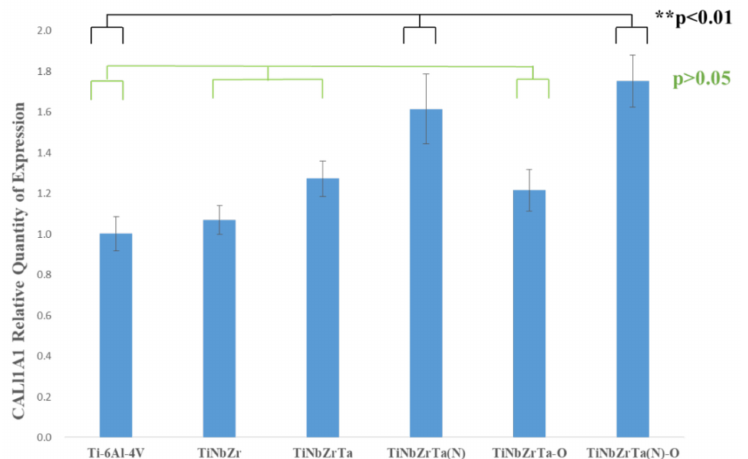
Figure 11. Col1 α 1 gene expression of L-929 cultured on uncoated Ti-6Al-4V and TiNbZrTa series films for three days. ** represents significance among groups ( p < 0.01); no asterisk represents nonsignificance among groups ( p >